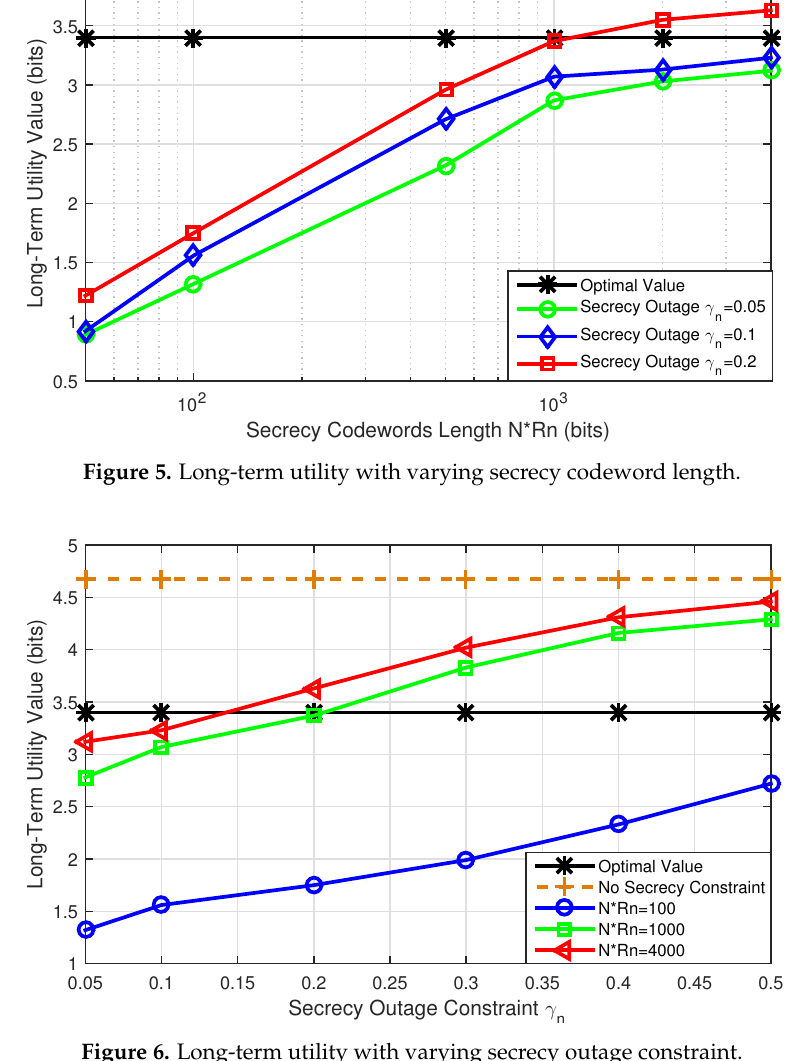
Figure 6. Long-term utility with varying secrecy outage